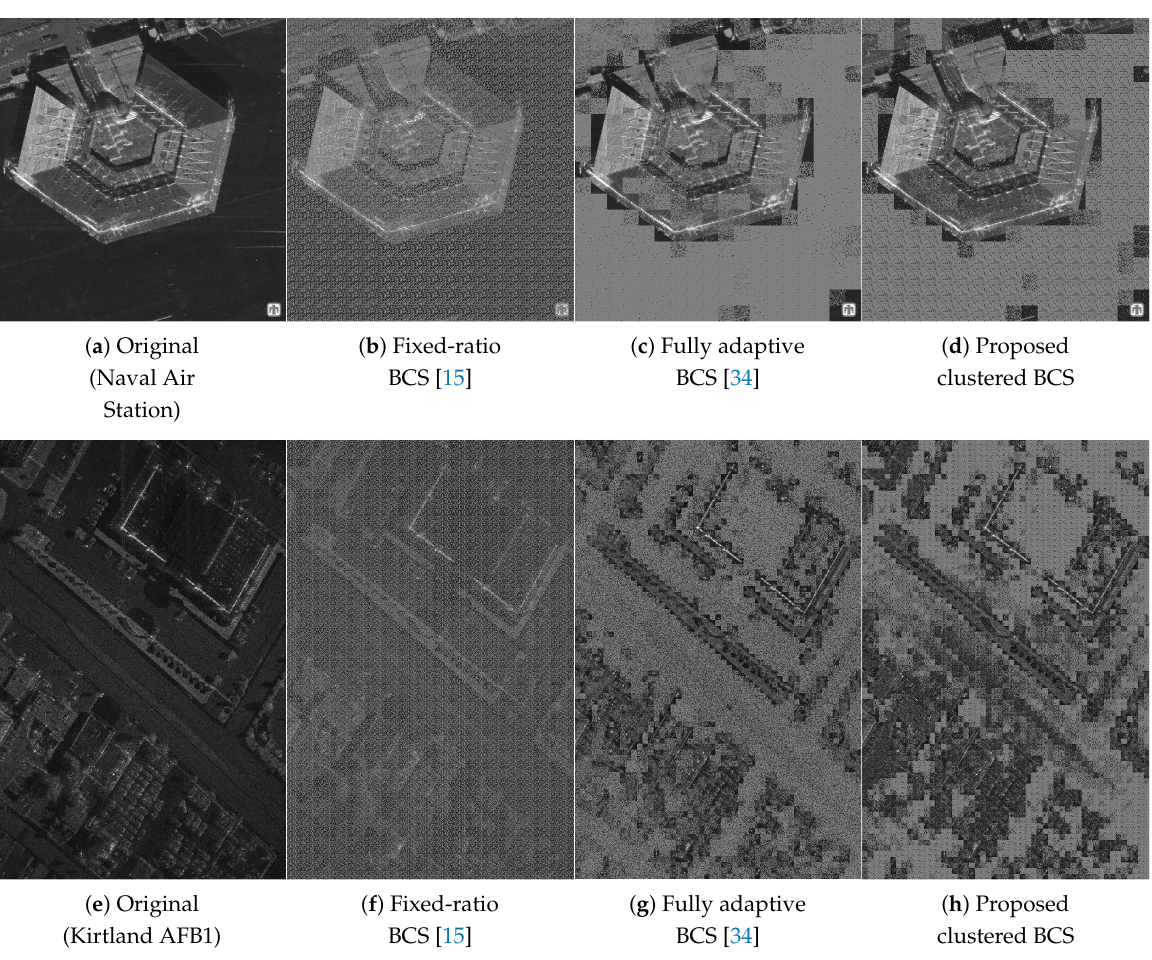
Figure 8. Random sampled SAR images using various BCS methods when r =